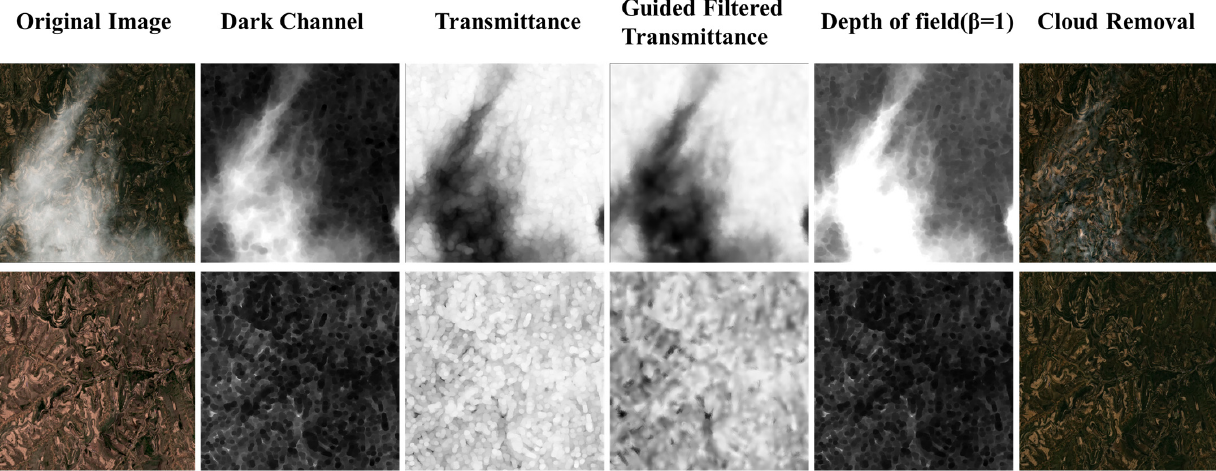
Figure A2. Intermediate results of the Dark Channel method for de-clouding.